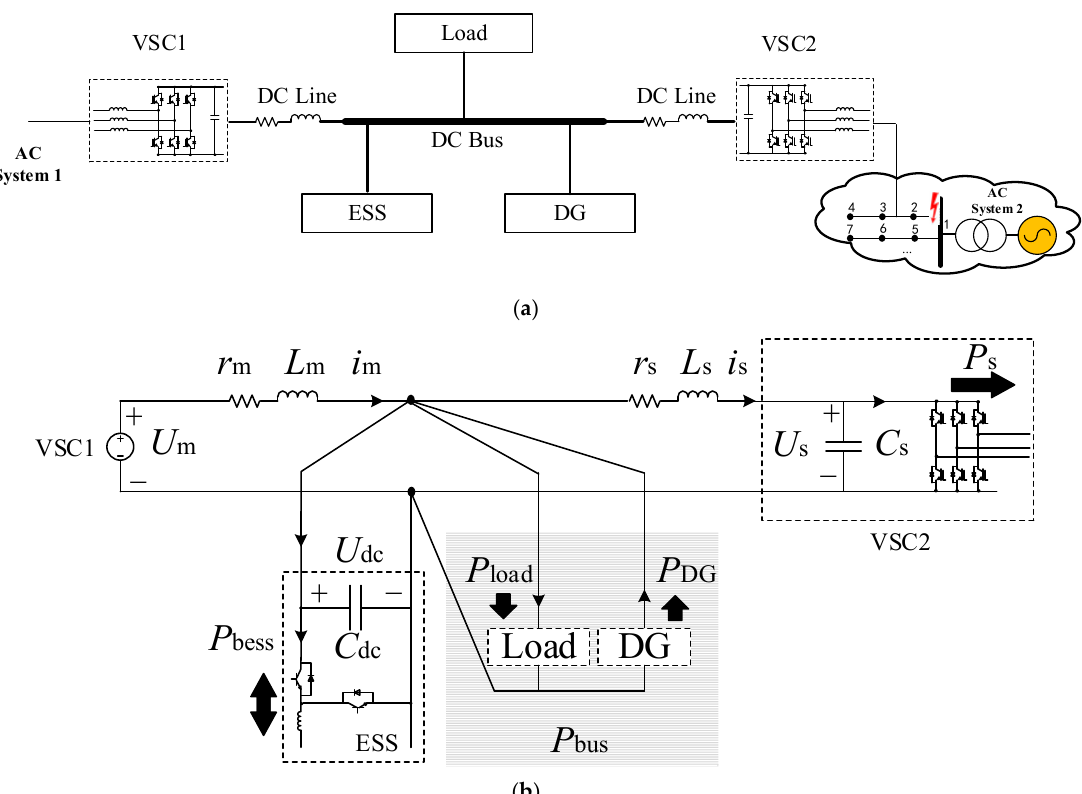
Figure 3. System structure and the equivalent circuit. ( a ) System structure under failure at one VSC; ( b ) Equivalent circuit.